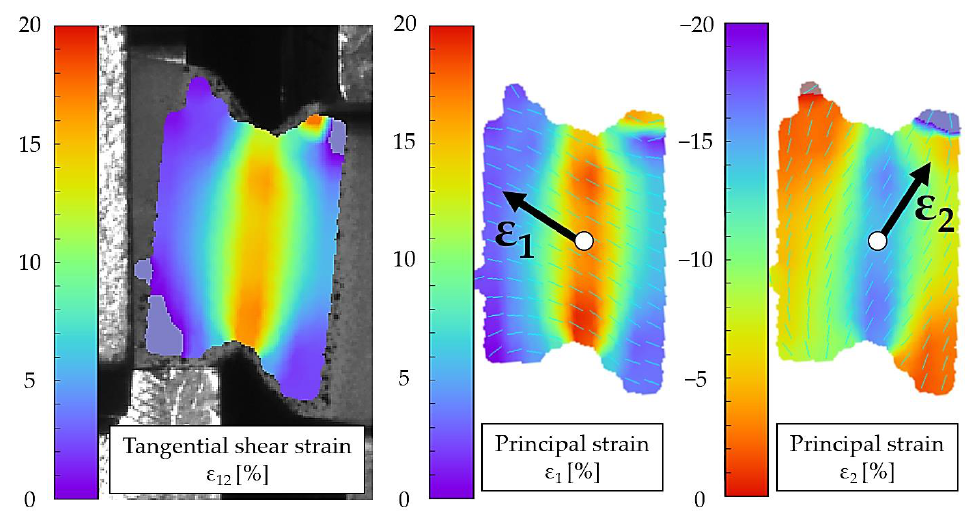
Figure 7. Contour plots of the tangential shear strain and resulting principal strains in the simple shear test for Neukadur ® and a displacement of 5 mm.